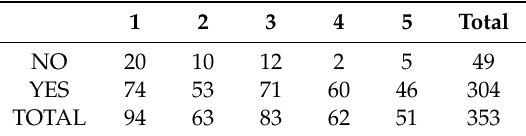
Table 5. Relevance of the cost of publication in choosing the Open Access journal (1 to 5), compared with the reduction of Open Access fees as an incentive measure (YES / NO).